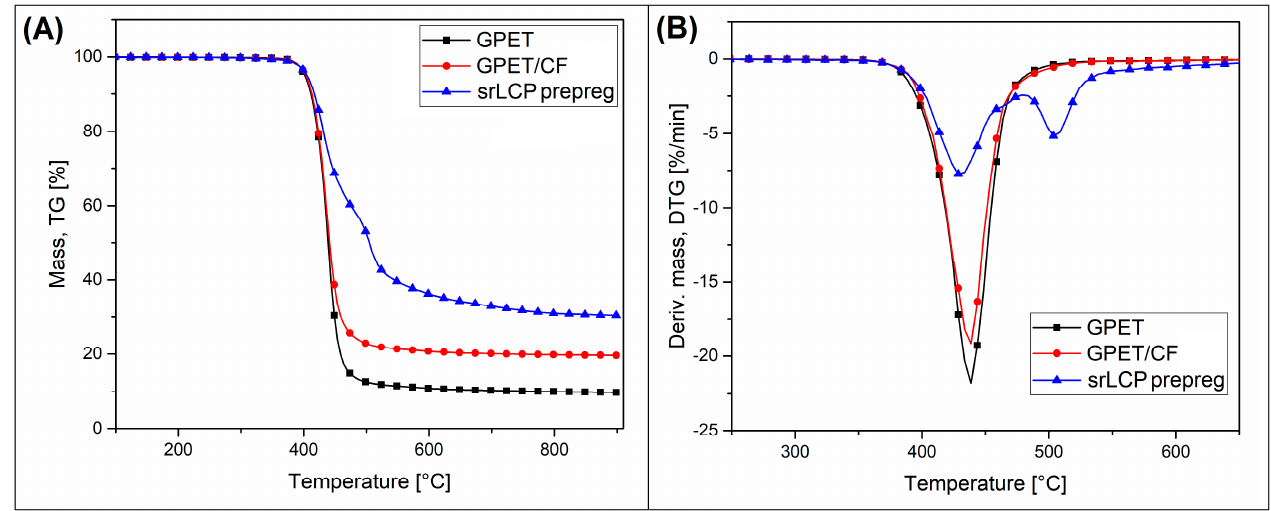
Figure 2. TGA analysis thermograms of the basic materials: GPET and GPET/CF filaments and LCP composite. ( A ) TG mass loss plot and ( B ) DTG derivative mass loss plot.